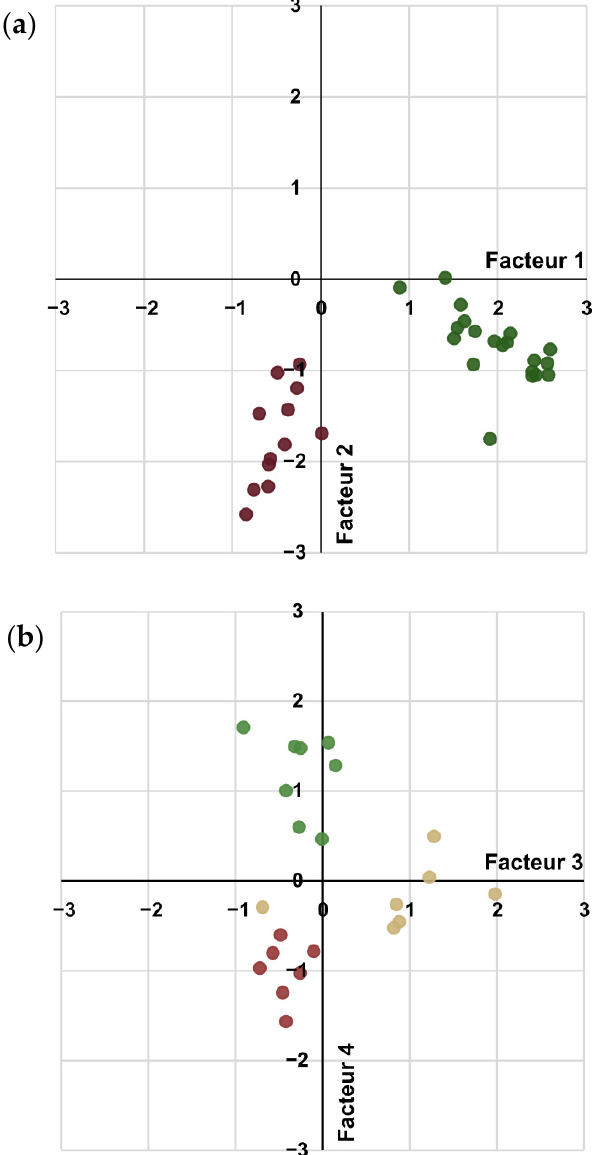
Figure 9. Response pattern identified by multi-factorial analysis: ( a ) Factorial plane between factors 1 and 2;